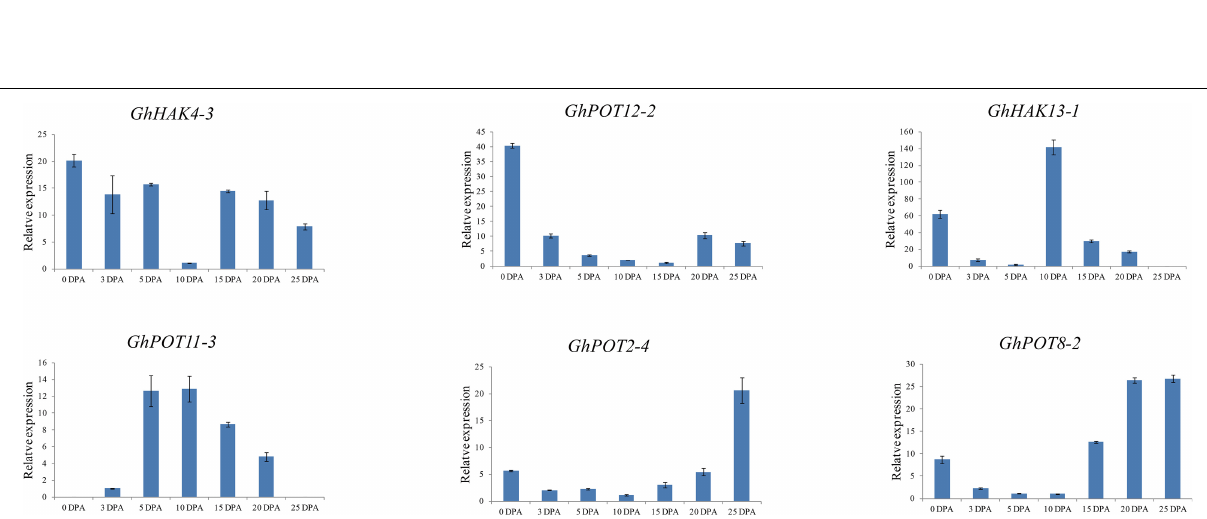
Frontiers in Genetics |